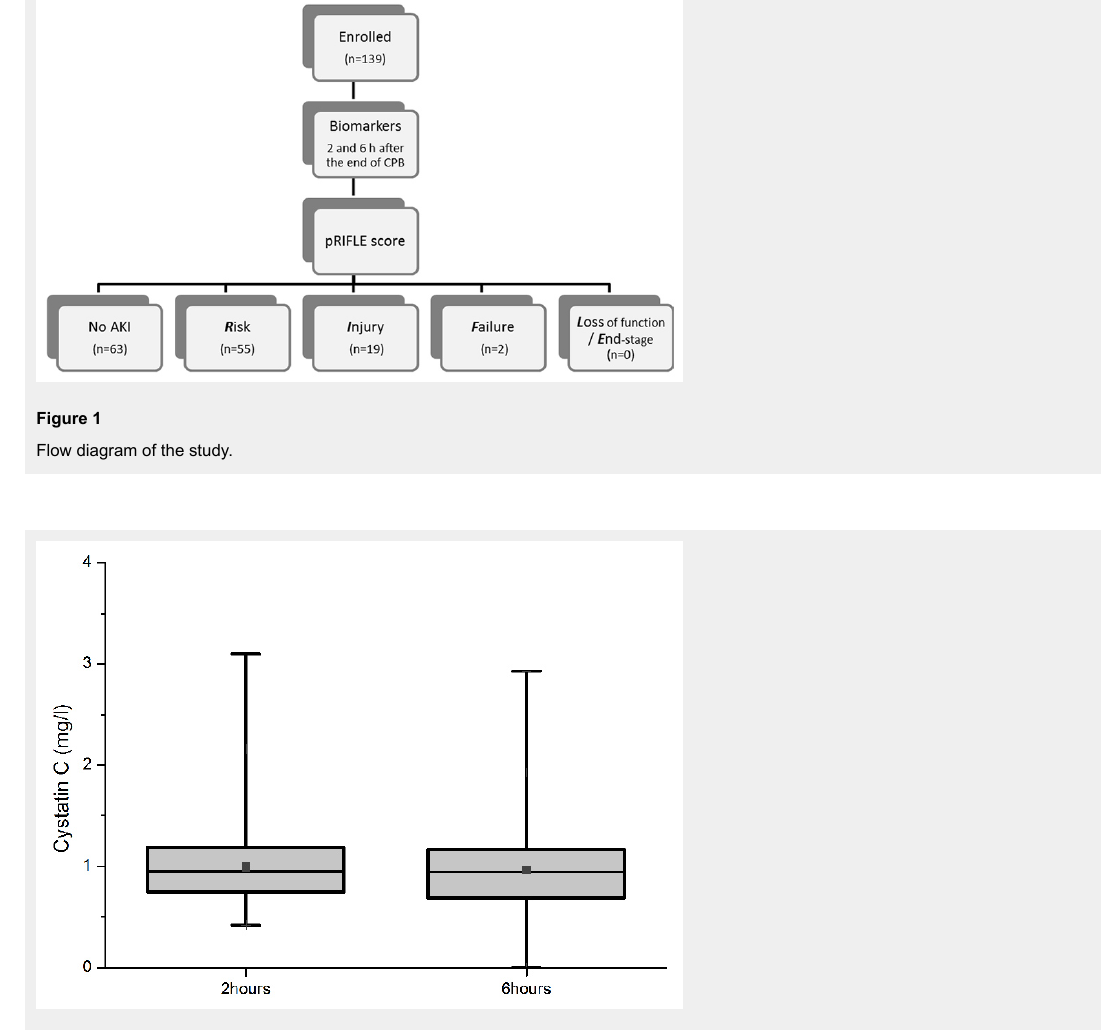
Figure 2 Box and whisker plot of serum Cystatin C concentrations 2 hours and 6 hours after the end of cardiopulmonary bypass. Boxes: 25 th percentile (bottom line), median (middle line), and 75 th percentile (top line); bars: range; squares: